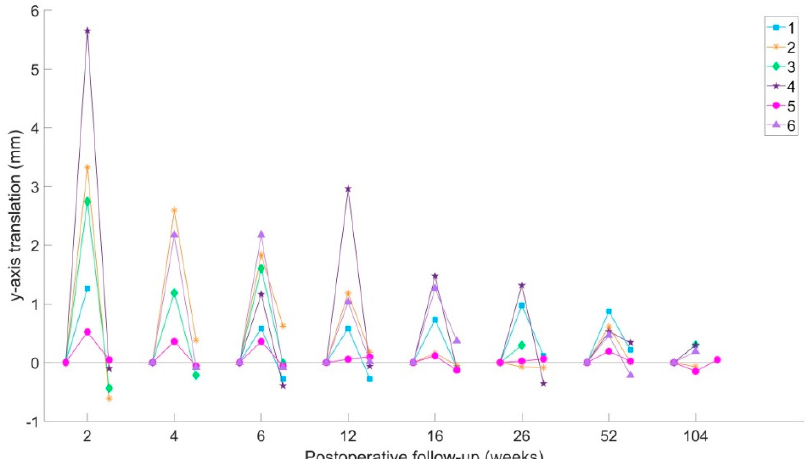
Figure 7. Load-dependent y-axis translations of the injured side ilium. Positive values showing cranial displacements of the ilium relative to the sacrum. Value for the supine (pre-load), standing (load) and supine after standing (post-load) position are shown for each time point.